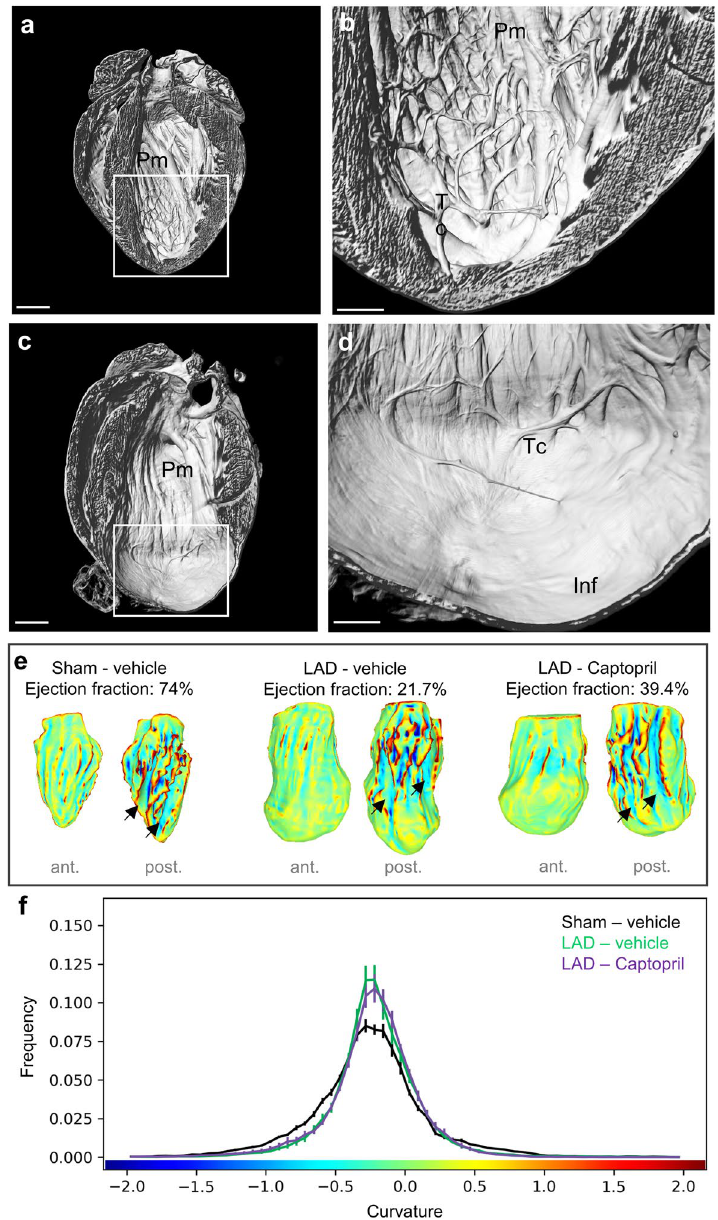
Figure 4. Light sheet imaging of left ventricle chamber topology. ( a ) Surface rendering of sham-operated light sheet imaged heart. ( b ) Magnified image demonstrates high optical resolution, intact papillary muscles (Pm) and dense distribution of trabeculae carneae (Tc). ( c ) Surface rendering of LAD-ligated light sheet imaged heart. ( d ) Magnified image demonstrates MI-induced changes in left ventricle (LV) chamber. Loss of trabeculae carneae (Tc) is evident in the dilated infarct area (Inf). ( e ) LV chamber surface is color-coded, with blue colours denoting concave surface and red convex surface areas (ant.—anterior view; post.—posterior view). Green indicates smooth surfaces. Outward dilation of the LV chamber is visible in LAD ligated hearts. Indentations left by papillary muscles are indicated by arrows. Lack of curvature is visible in the posterior view of the LAD— vehicle heart, with papillary muscle and trabecular indentations absent from the apex. Ejection fraction (%) is shown for the selected hearts performed 5 weeks after surgery. ( f ) Quantitative analysis of LV chamber mean curvature. Analysis was carried out in the lower apical half the LV chamber and the group mean value is shown on the frequency distribution histogram. Data is presented as mean ± s.e.m., n = 8–10. Scale bars: ( a , c ) 1 mm; ( b , d ) 300